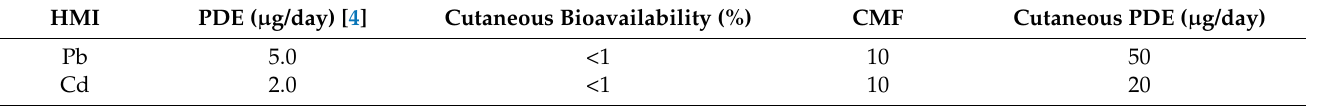
Table 4. Results of the calculation of the skin PDE for Pb and Cd. Cutaneous Bioavailability